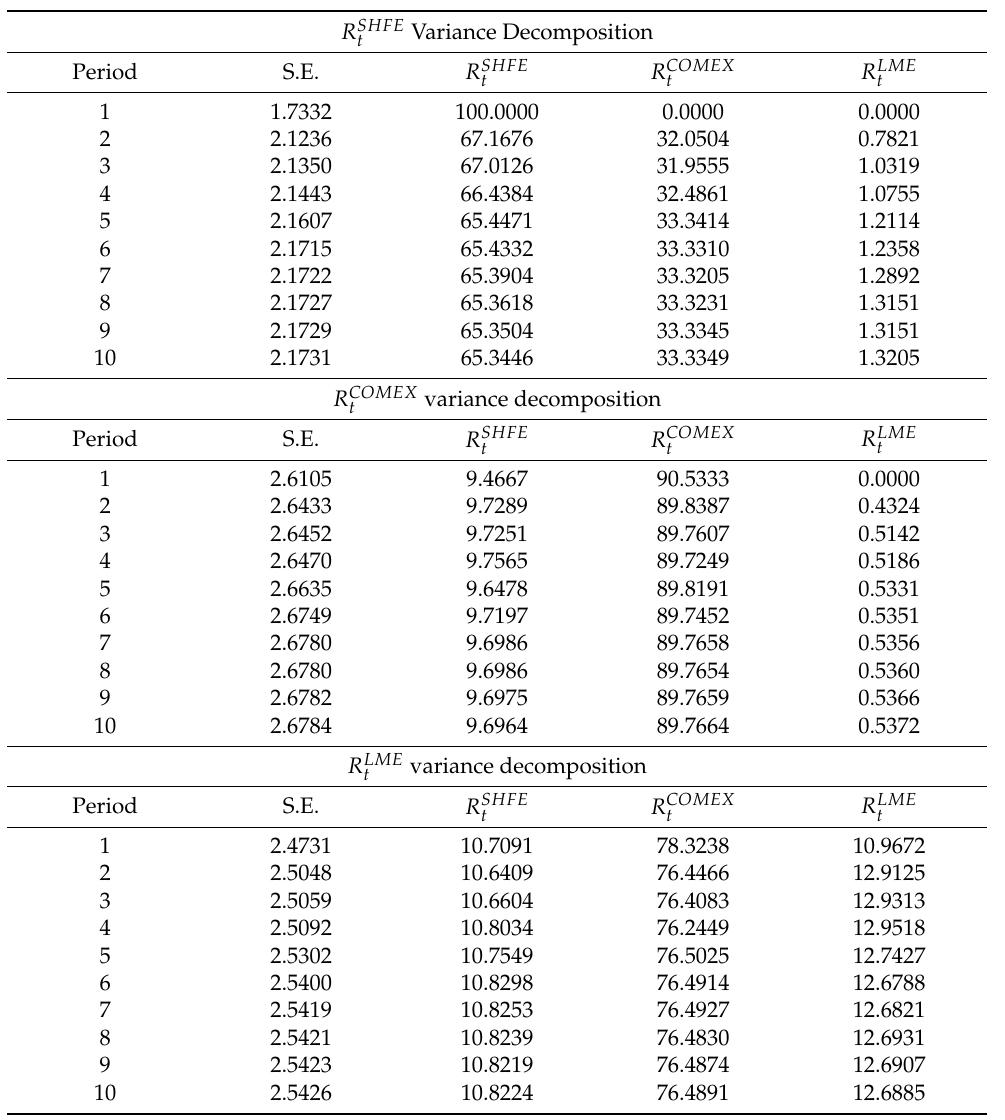
Figure 6. Impulse response of SHFE to LME copper yield. Figure 5 shows that the initial impact of New York copper on the yield of Shanghai copper is zero, then increasing to a peak of 0.83 in the second period. The impact of the third period is already weaker, and that of the sixth period is not significant. Figure 6 indicates that the impact of London copper on the return rate of Shanghai copper is zero at the beginning, the impacts from the first to the eighth periods are alternately positive and negative, and the impact from the eighth period is not significant. In Table 6, it is observed that the variance of the sequence of Shanghai copper return rate in the first period is caused by its disturbance. In the second and tenth periods, 67% to 68% of the disturbances are caused by itself, and around 31% of the disturbance is caused by New York copper, which is significantly greater than the effect of the London copper return rate. The variance of the New York copper yield sequence in periods 1–10 is caused by a disturbance of 76%, while the Shanghai cop- per yield sequence contributes by around 23%. Only a quarter of the variation in the copper yield sequence in London is caused by itself; around 46% of the disturbance is caused by the New York copper yield, and 25% of the disturbance is from the Shang- hai copper yield sequence.